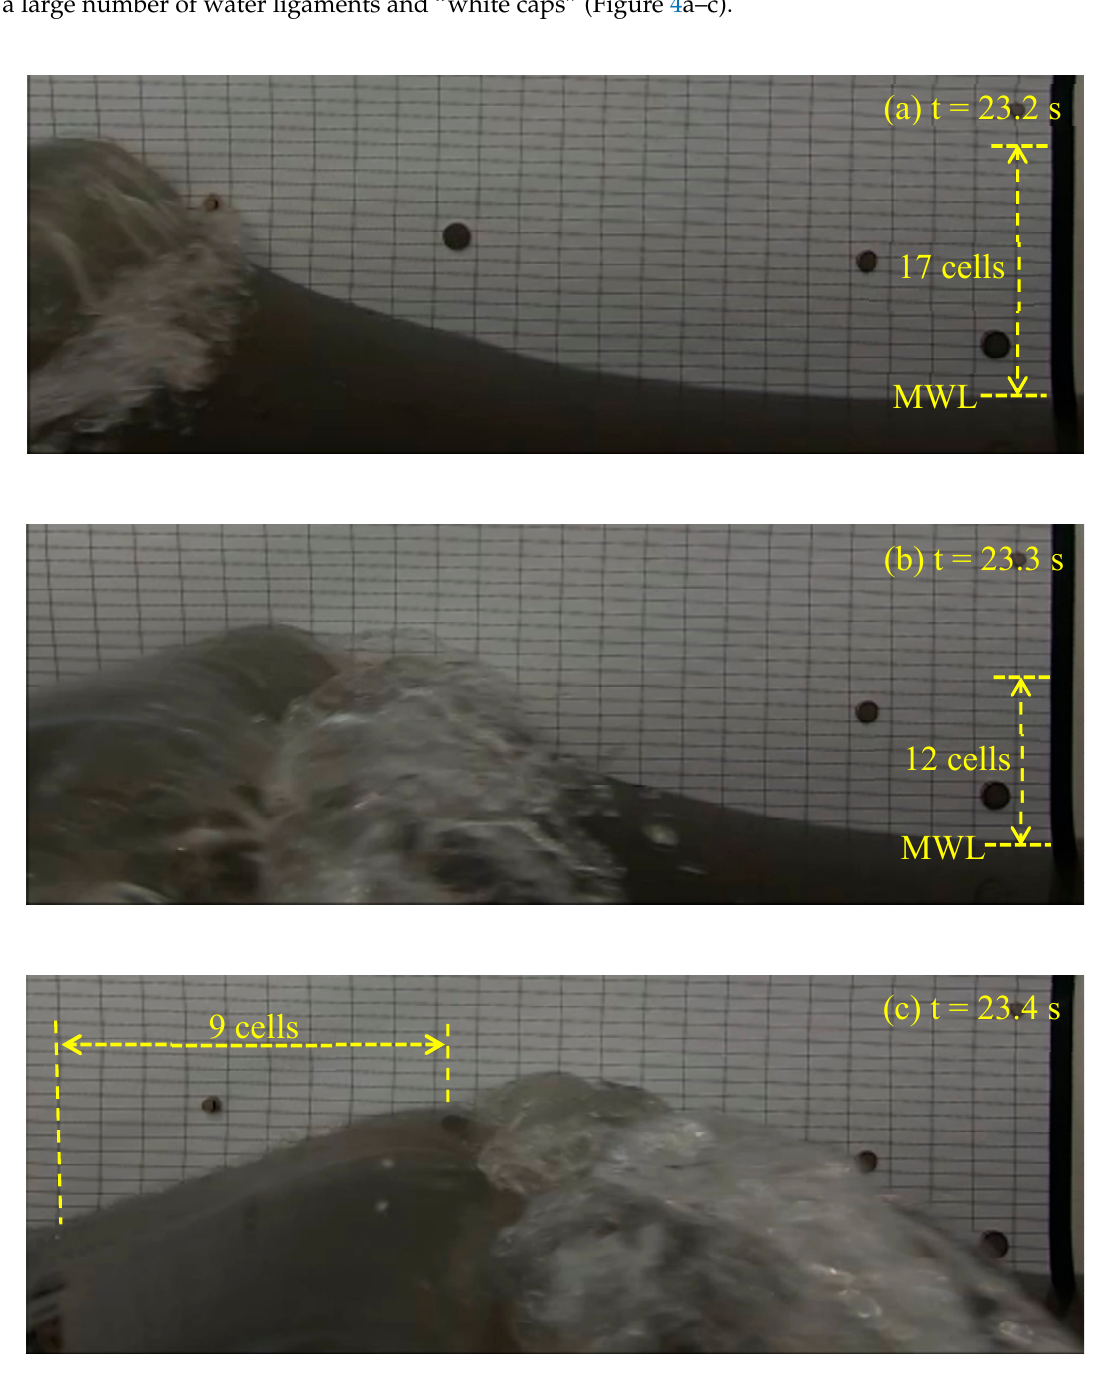
Figure 4. Side views of the breaking wave at various times taken by the GoPro camera: ( a ) the plunging breaker, ( b ) the water splashup, and ( c ) the secondary breaker. MWL stands for the mean water level. The dimension of the cells on the paper is 3.85 (L) × 1.3 (W) cm.